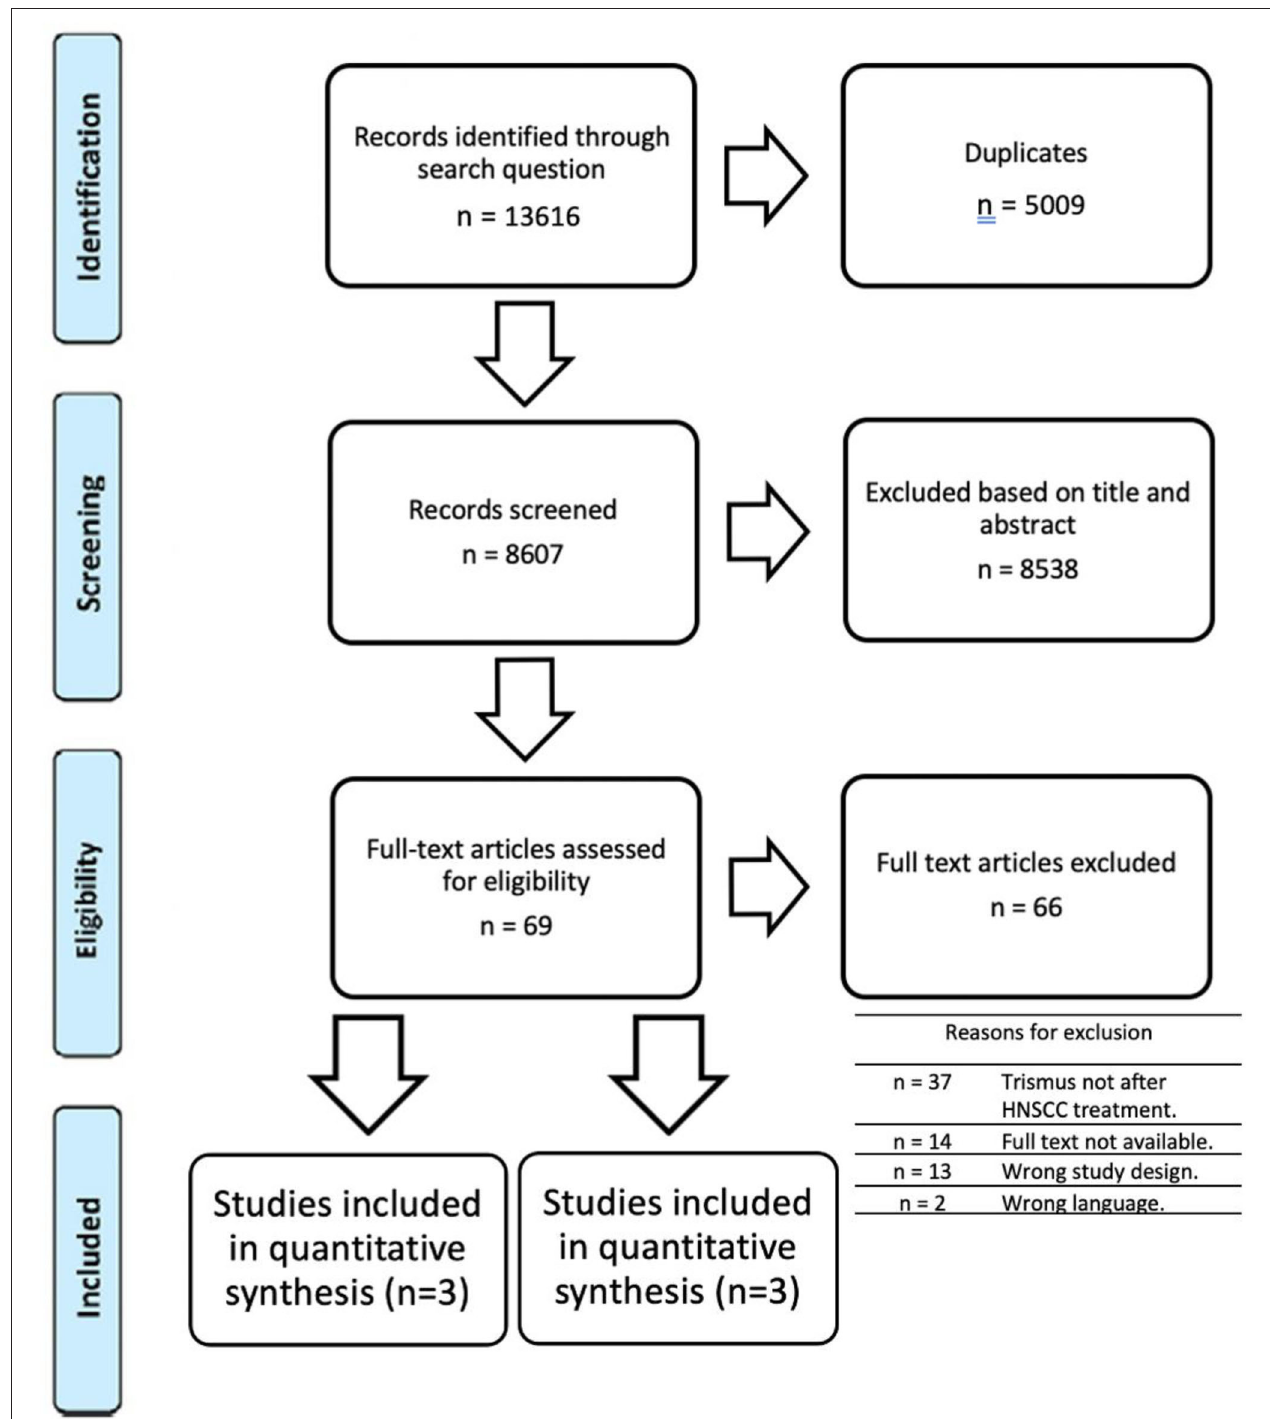
FIGURE 1 | Prisma flow